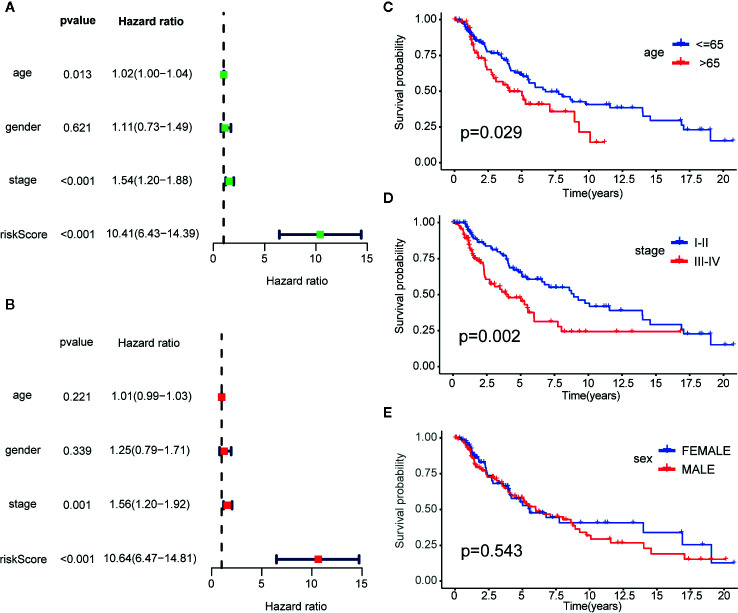
Cox proportional hazards model and stratified analysis of the training cohort revealed 23-IRGP was a independent prognostic factors. (A) Age, stage and risk score were the independent prognostic factors in Univariate Cox analysis. (B) Stage and risk score were the independent prognostic factors in Multivariate Cox analysis. Stratified analyses applied by age (p = 0.029) (C), tumor stage (p = 0.002) (D) and sex (p = 0.543) (E) demonstrated the predictive of 23-IRGP in OS of CM patients.